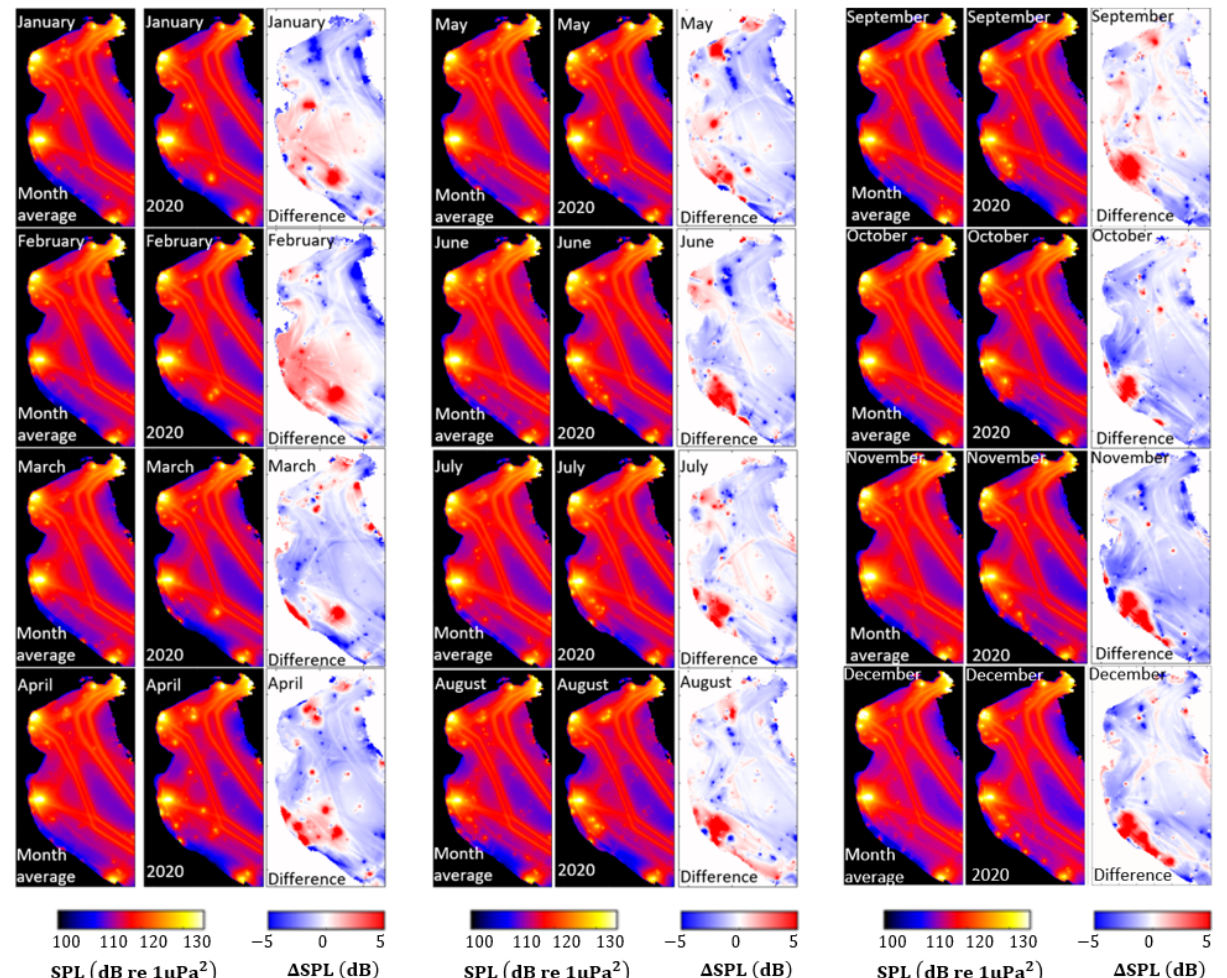
Figure 11. The monthly averaged sound maps before (as a month-average of 2017 to 2019 sound maps) and during the pandemic (2020) in test area 2. The frequency band is from 100 Hz to 10